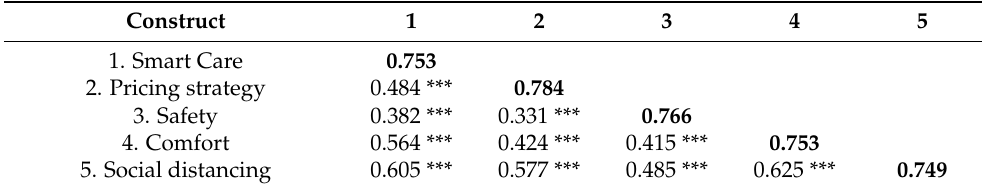
Table 6. Result of discriminant validity (Fornell-Larcker).